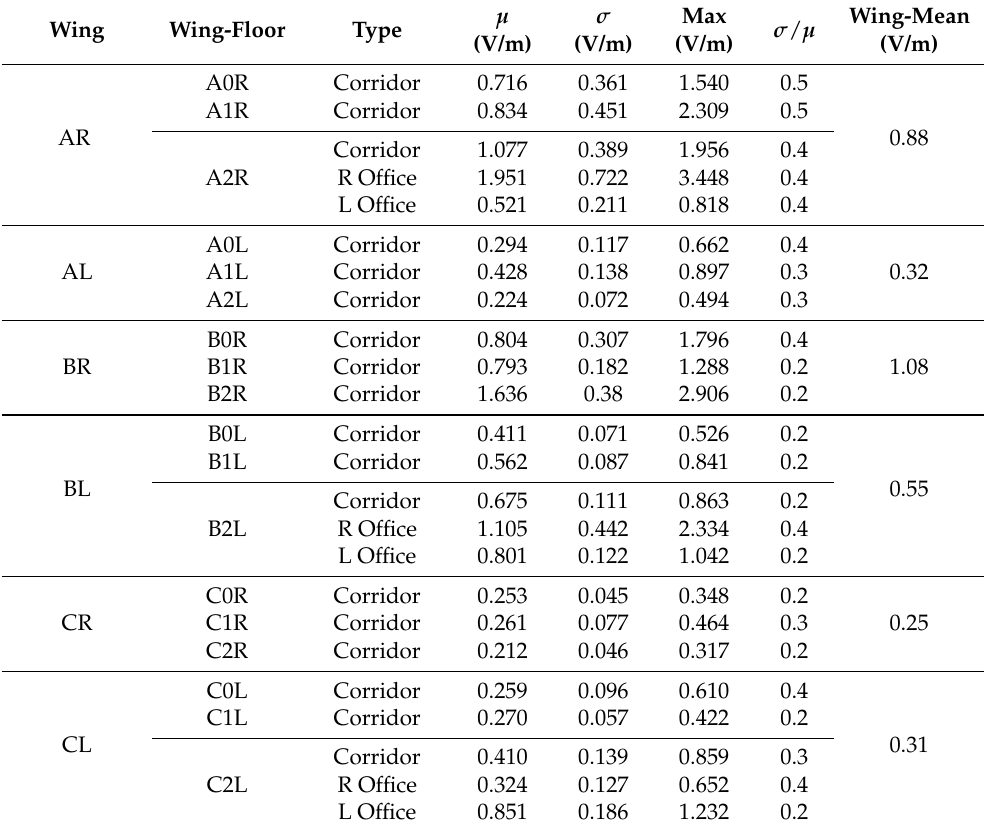
Table 7. Mean, maximum, and standard deviation of measurements in A, B, and C